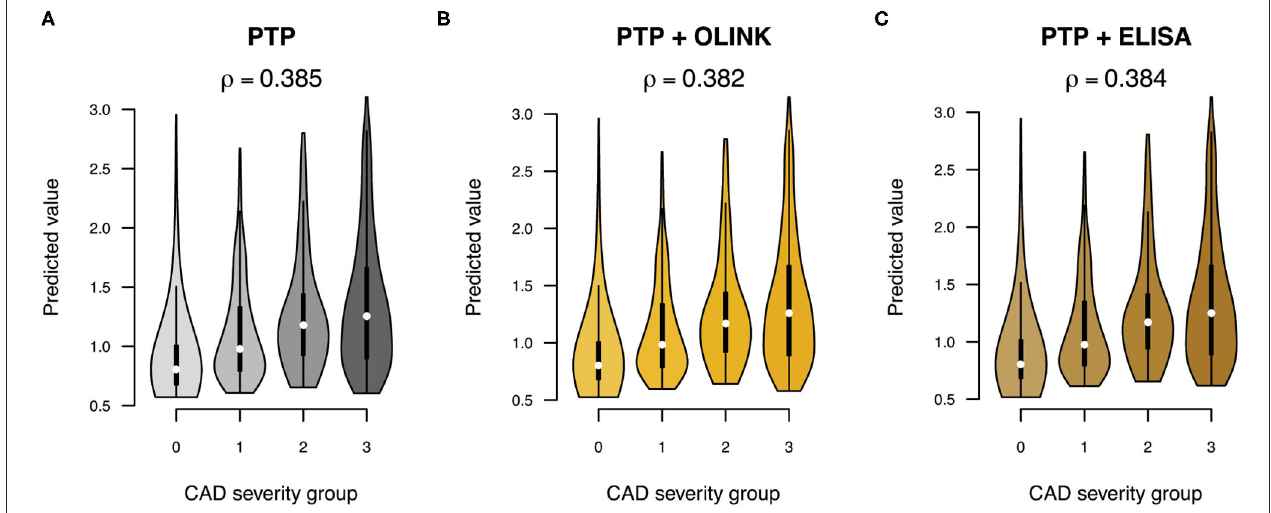
FIGURE 5 | Prediction of CAD severity (0: no CAD, 1: mild CAD, 2: moderate CAD, 3: severe CAD) using (A) pretest probability (PTP) without and with sortilin measurements by (B) OLINK and (C) ELISA. The overall correlation ( ρ ) between predicted value and CAD severity group across the five validation sets is indicated above each